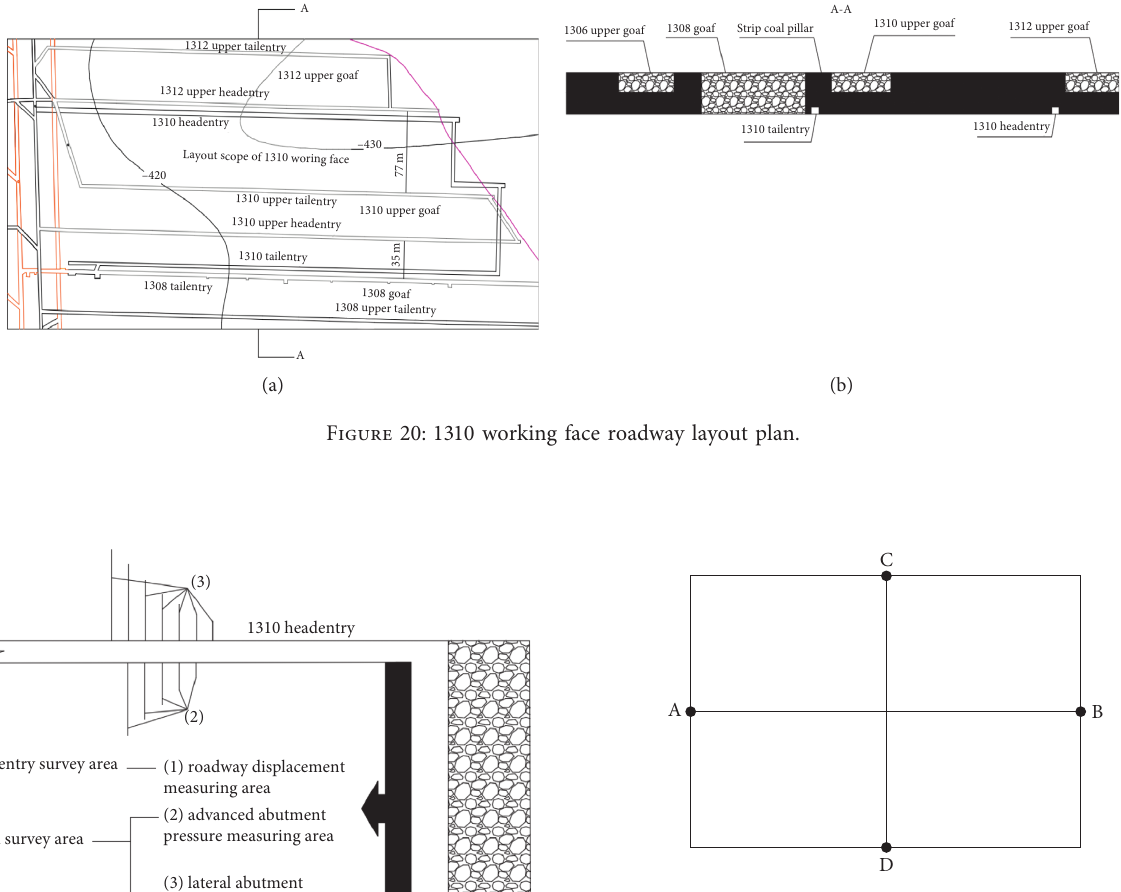
Figure 22: Layout of measuring points in